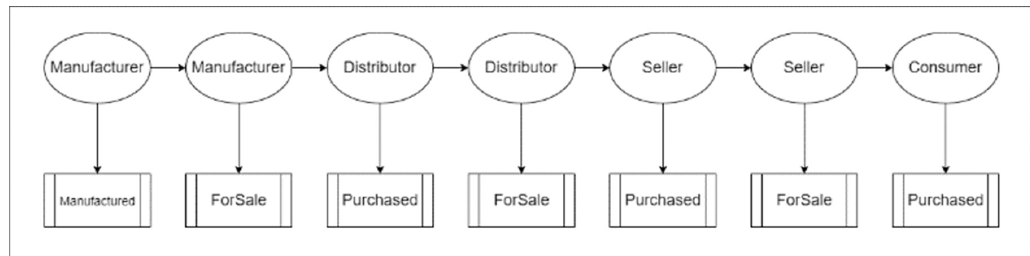
Fig. 4. Overall flow of a project